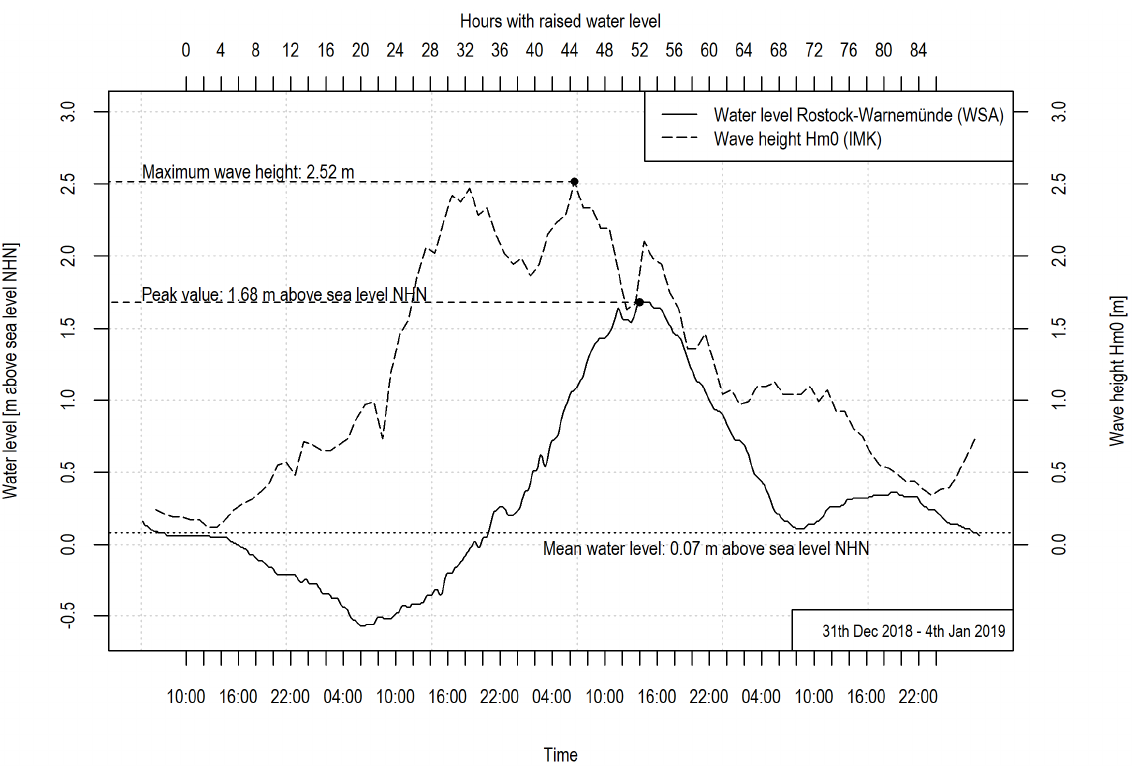
Figure 19. Water level and wave height of the storm surge “Zeetje”.